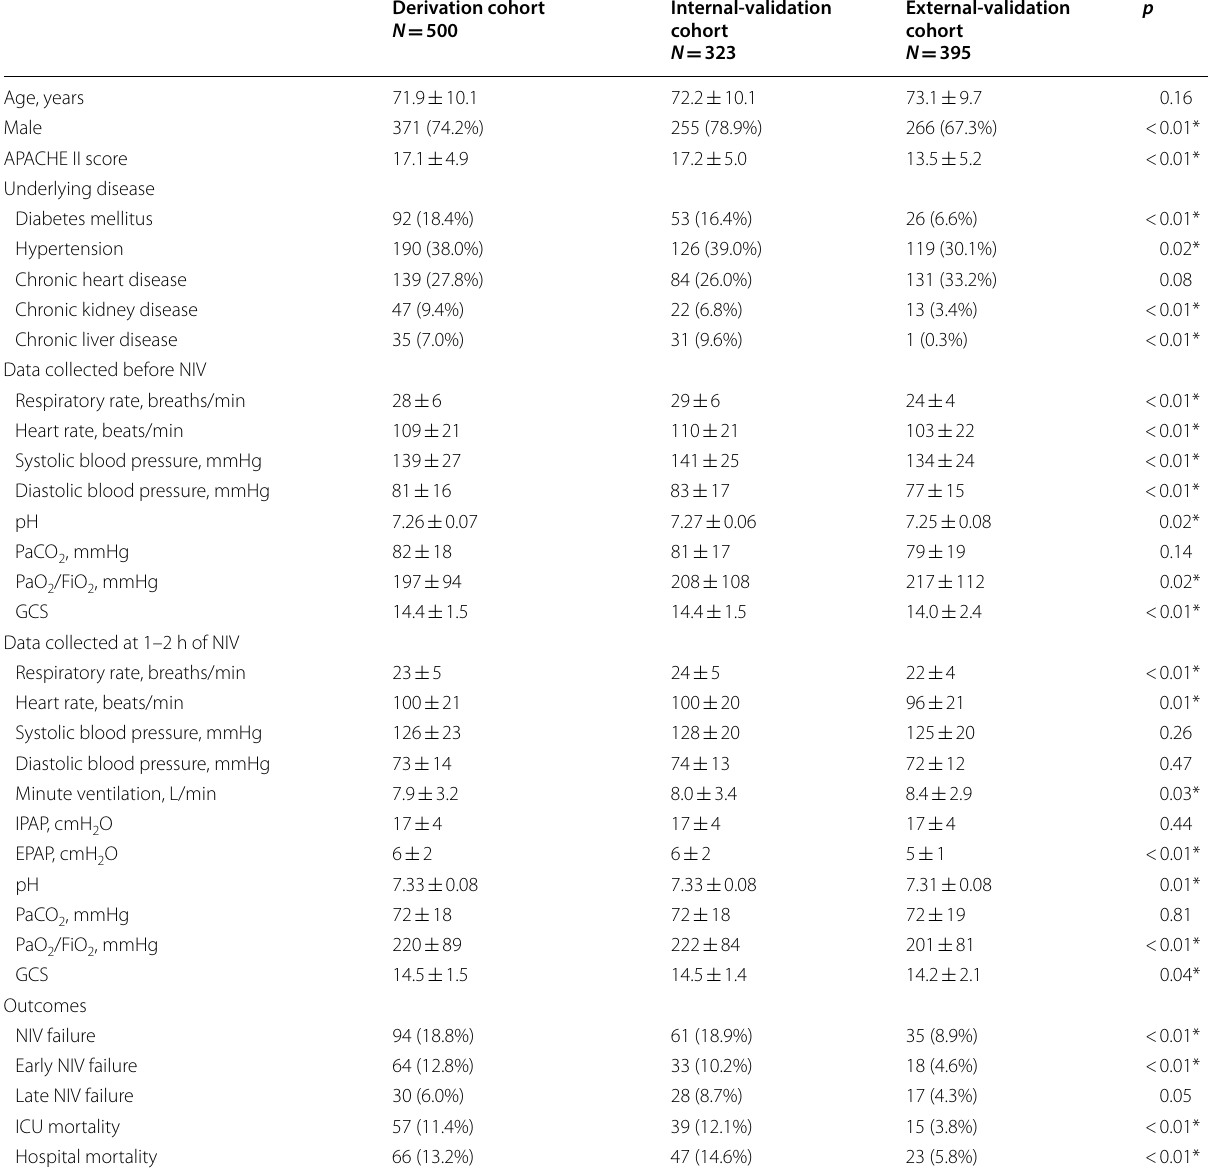
Table 1 Demographics among the derivation, internal-validation, and external-validation